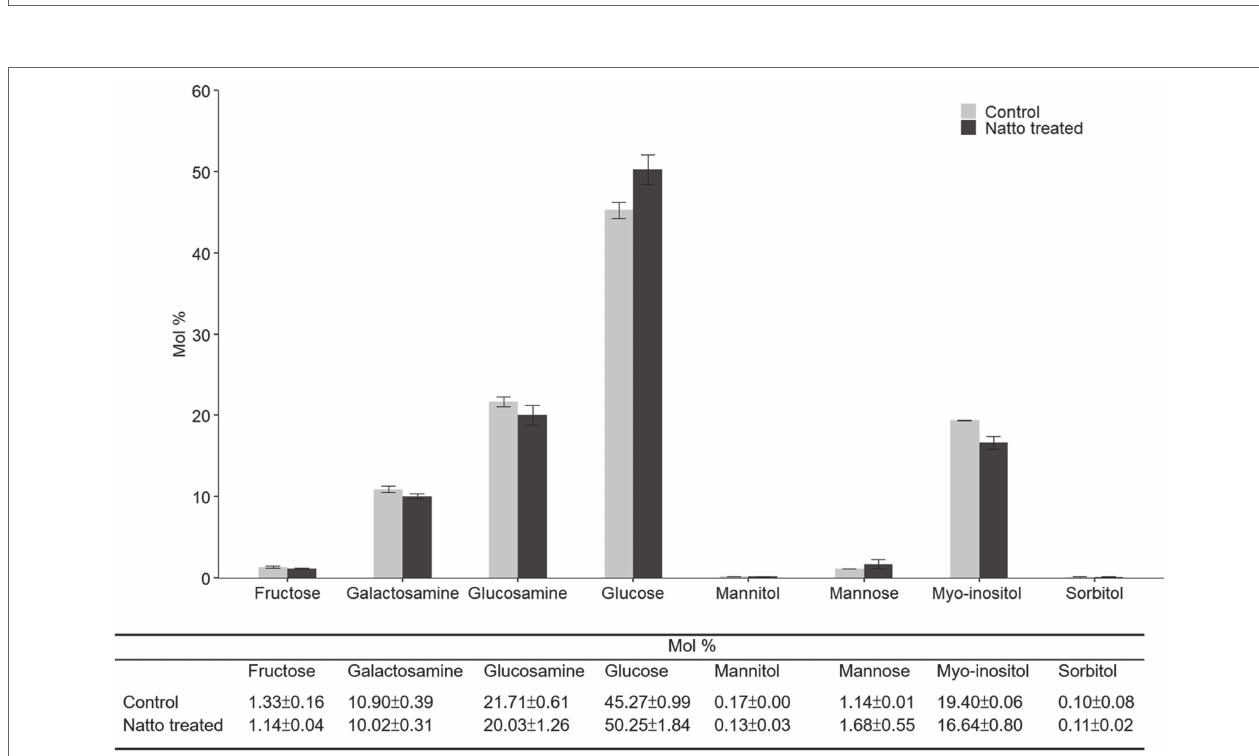
FIGURE 6 | Carbohydrate composition of purified polysaccharides obtained from the E. faecalis cell envelope. E. faecalis OG1RF was anaerobically cultured in M9B broth without or with B. subtilis natto supernatant (0 and 10 v/v) for 24 h. The polysaccharides in the E. faecalis OG1RF cell envelope were purified for carbohydrate composition analysis using HPAEC. The data are presented as the means ± SDs ( n =